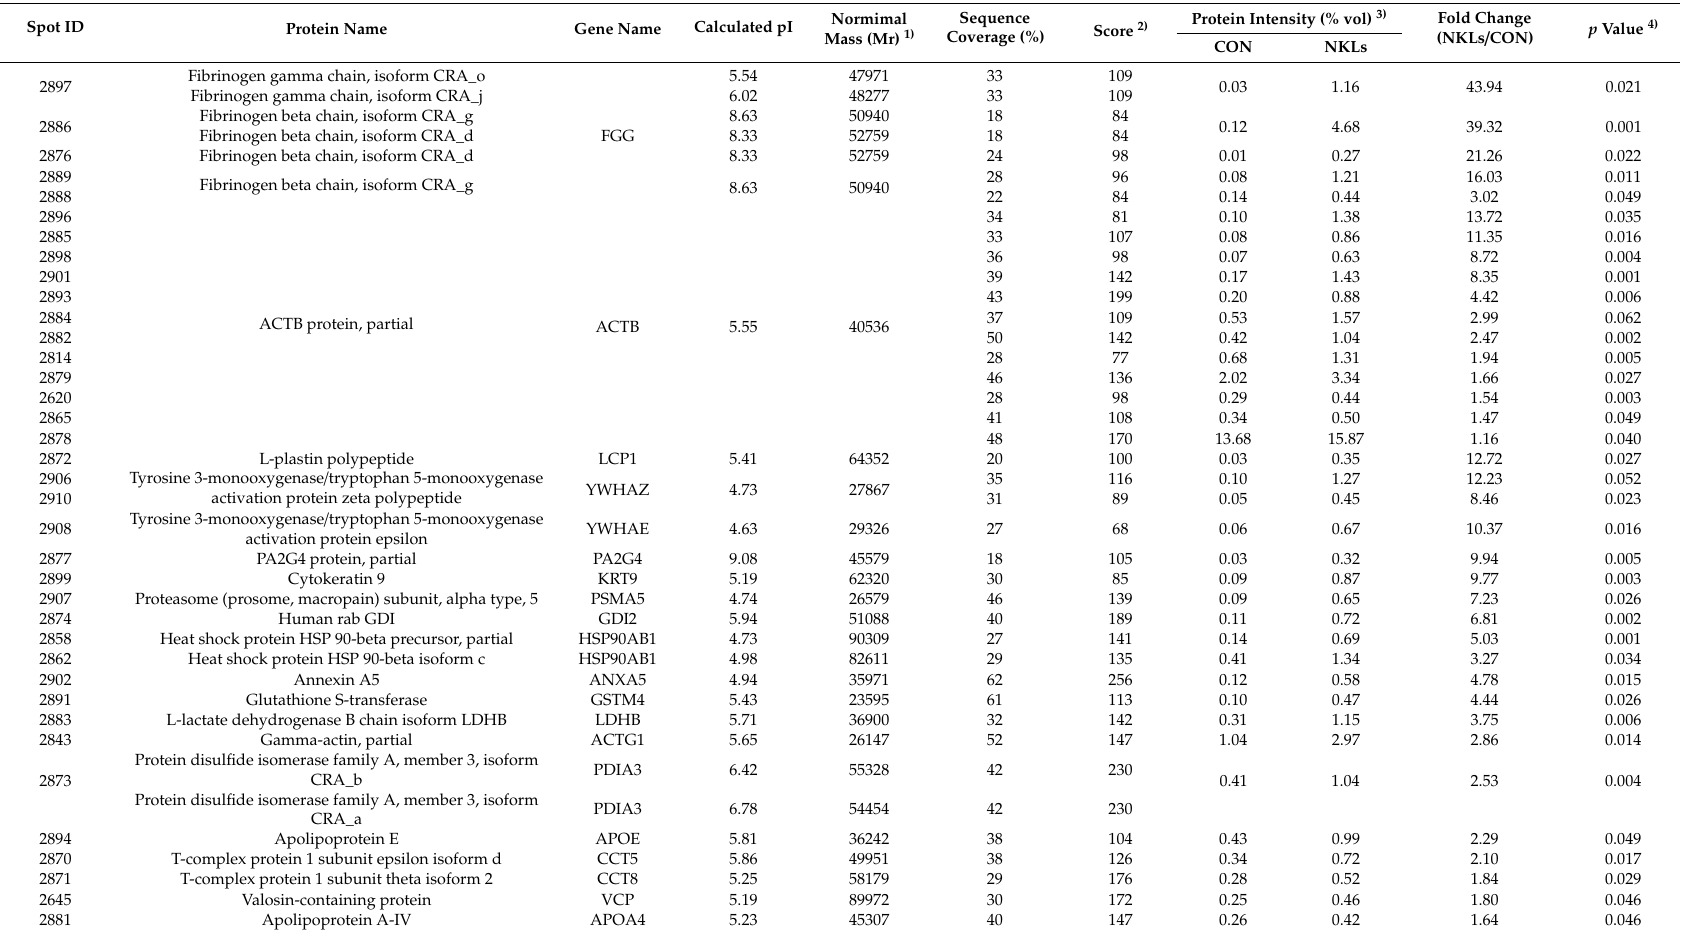
Table 1. List of identified proteins in isolated EVs by peptide mass fingerprinting (PMF)